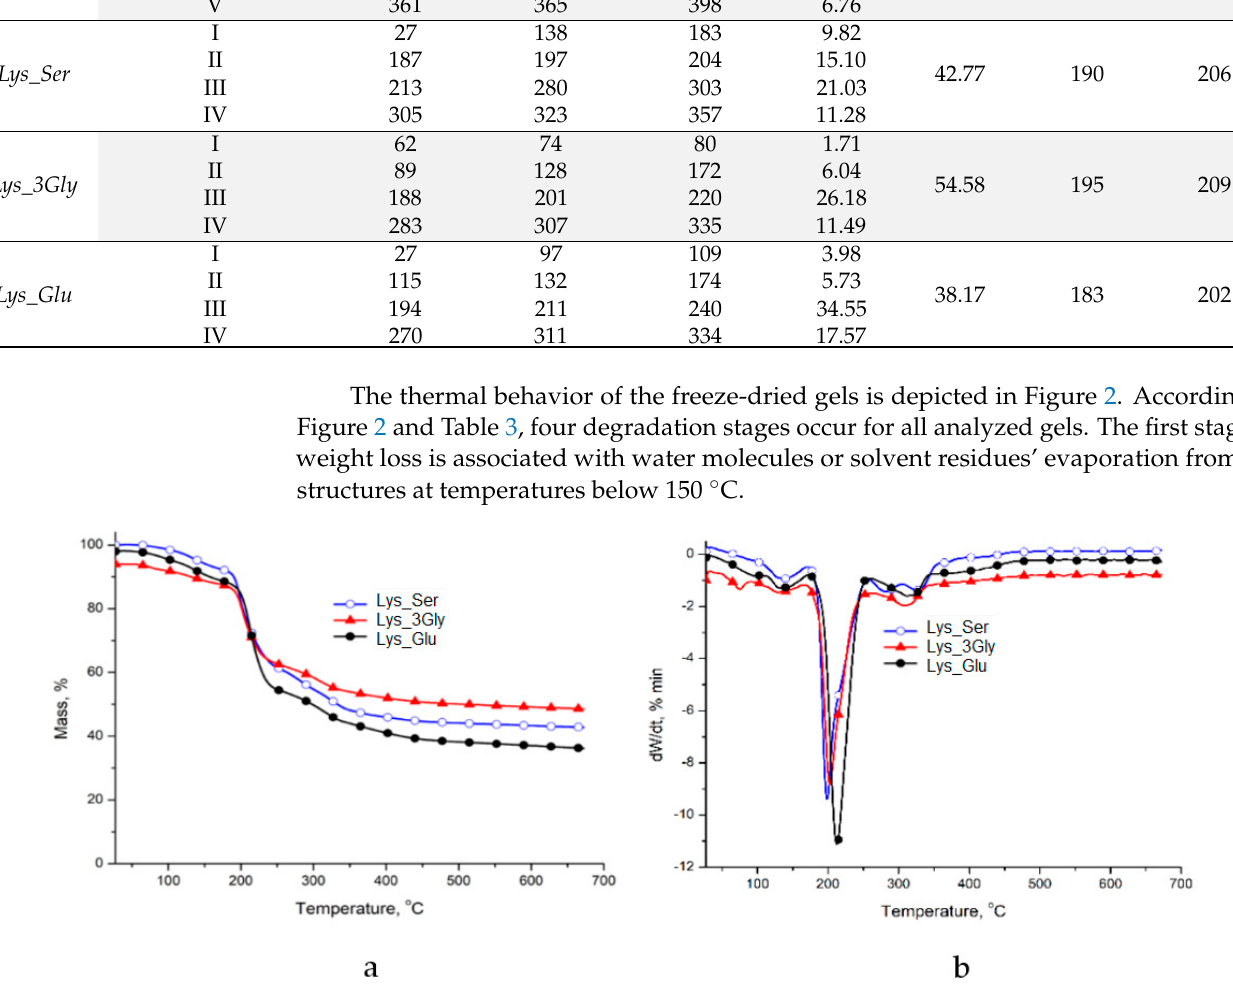
Figure 2. TG ( a ) and DTG ( b ) of the amino acid/peptide systems that formed supramolecular gels at a constant ratio (Fmoc-Lys-Fmoc: X = 5_1).